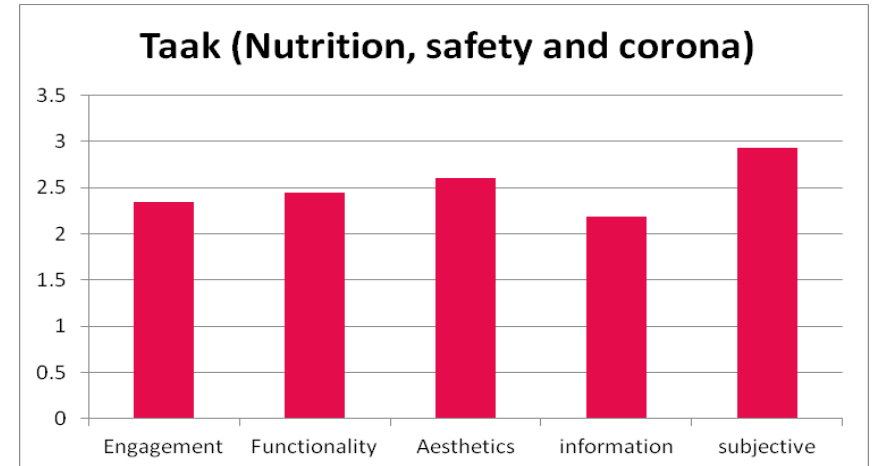
Fig 6. The evaluation of indicators in Taak (Nutrition, safety and corona) according to MARS subscales